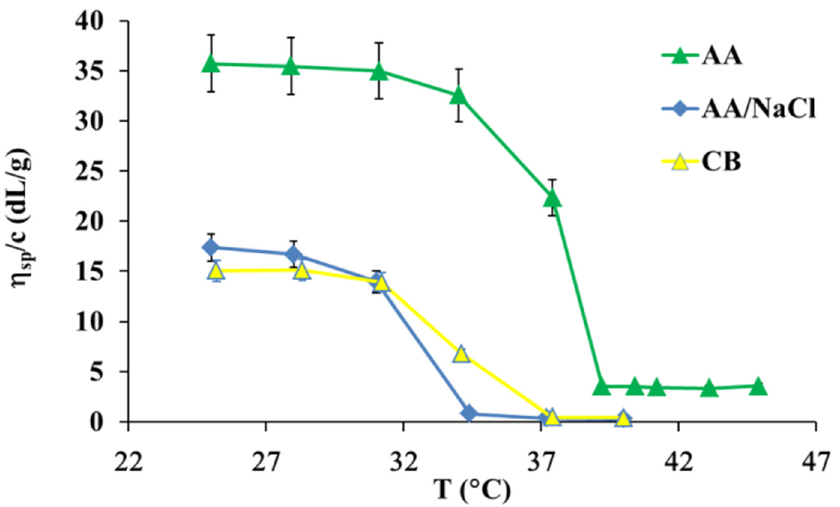
Figure 2. Plots of reduced viscosity vs. temperature for 0.5 mg/mL collagen solutions in three sol- vents.